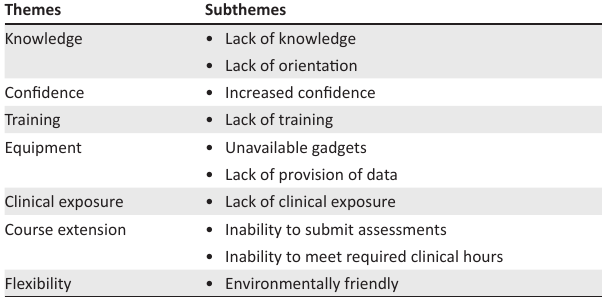
TABLE 2: Themes and subthemes.